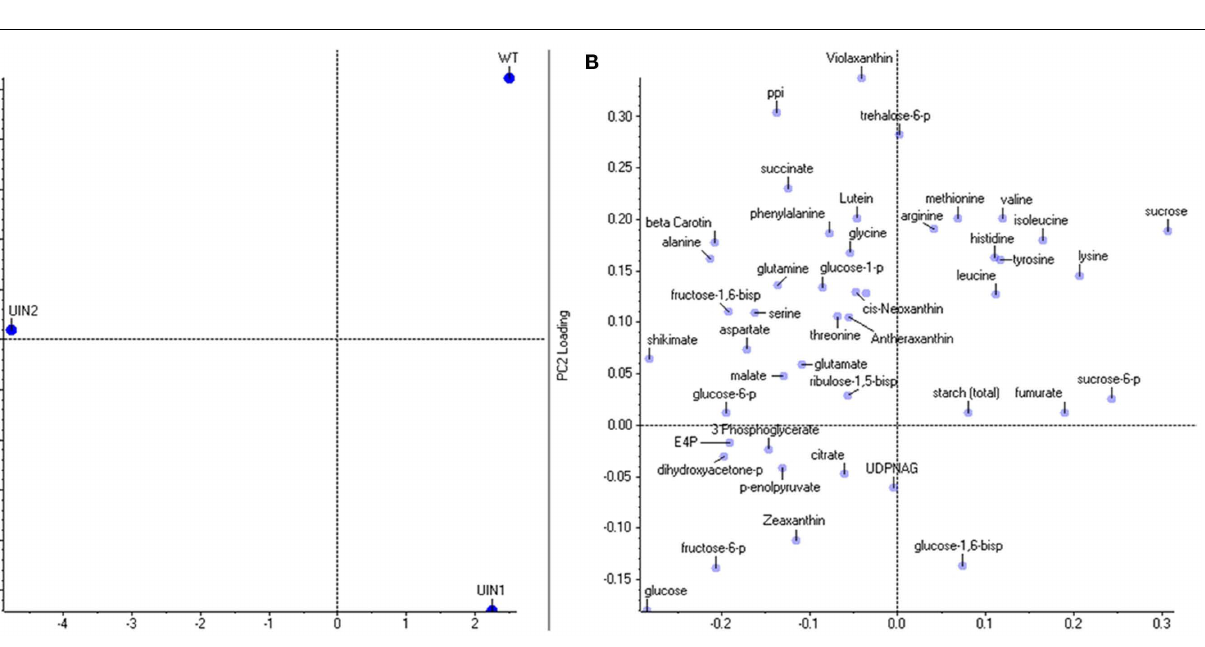
based on the number of features present from a particular group as a fraction of the total number of features in a specific functional group.